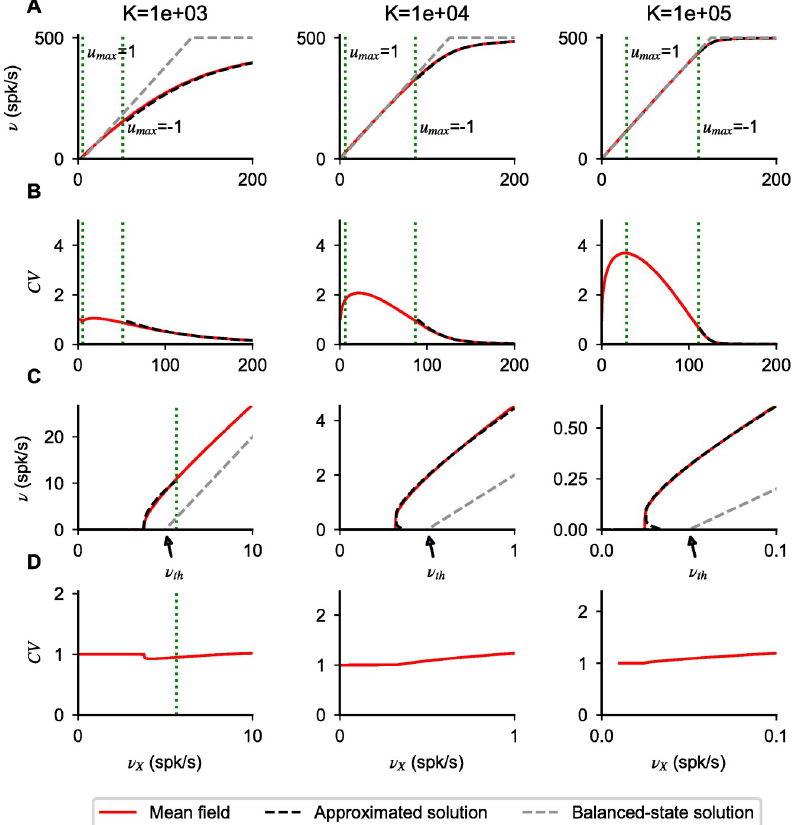
Fig 2. Types of nonlinearities in network response. ( A ) Network transfer function obtained solving numerically Eqs (3)–(5) for different values of K (indicated on top of each column). ( B ) CV of interspike interval distribution obtained solving numerically Eq (6) (red lines). ( C , D ) Plots as in A , B but zoomed in the region of response onset. In all panels, dotted green lines correspond to the values at which u max = 1 and u max = − 1, i.e. they indicate the separation between the different operating regimes mentioned in the main text. Firing nonlinearities at response onset and saturation are captured by approximated forms (black dashed lines) obtained for u max � − 1 (Eq (13)) and u max � 1 (Eq (15)), � 0, the transfer function approaches the balanced-state solution (gray dashed lines, Eq (17)); in respectively. For u max ffiffiffiffi p the region − 1 < u < 1, the first order corrections are of order 1 = and become negligible as K increases. In the K max suprathreshold regime ( u max � − 1), the CV approaches zero, i.e. firing becomes regular, with a decay with input strength captured by Eq 14 (dashed line). Parameters: J = 0.2 mV, g = 5.0, g X =